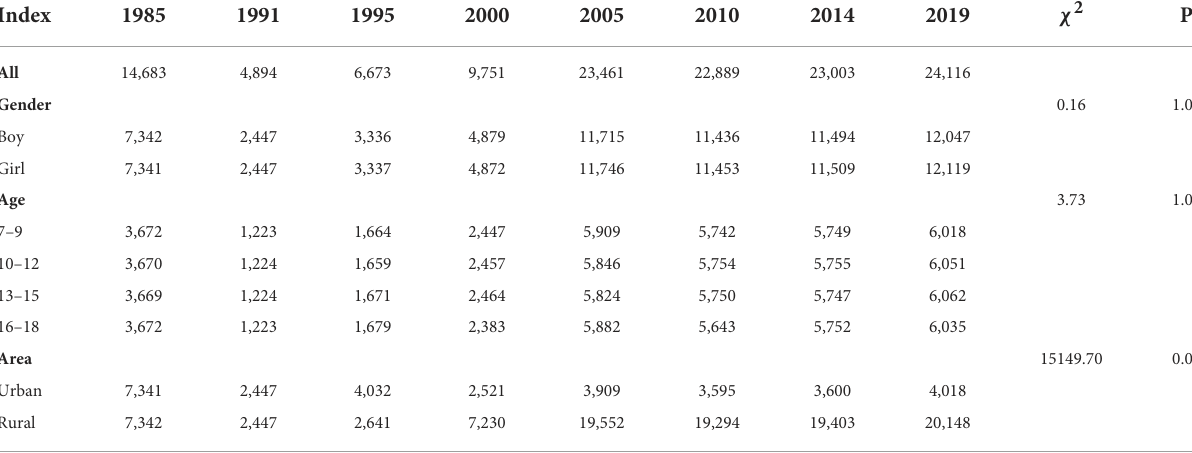
TABLE 1 The distribution of sociodemographic factors in survey children from 1985 to 2019.